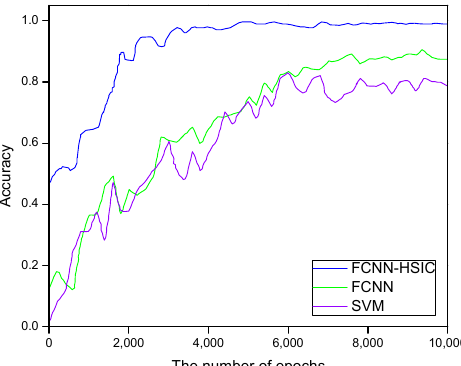
Figure 9. Accuracy of different models on the collected dataset.